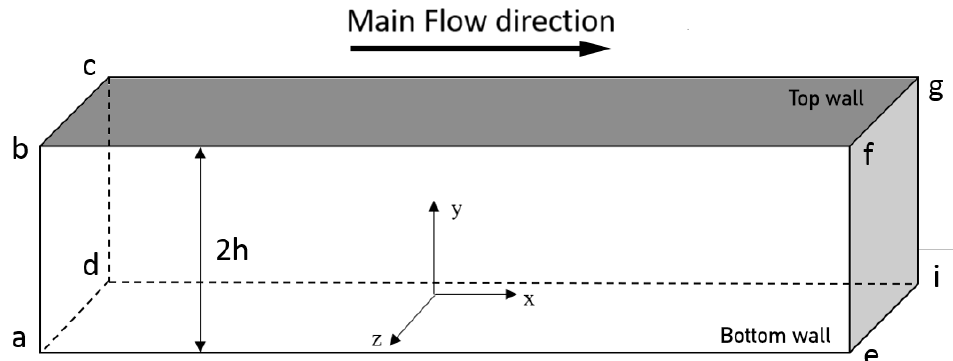
Figure 1. Details of the channel geometry